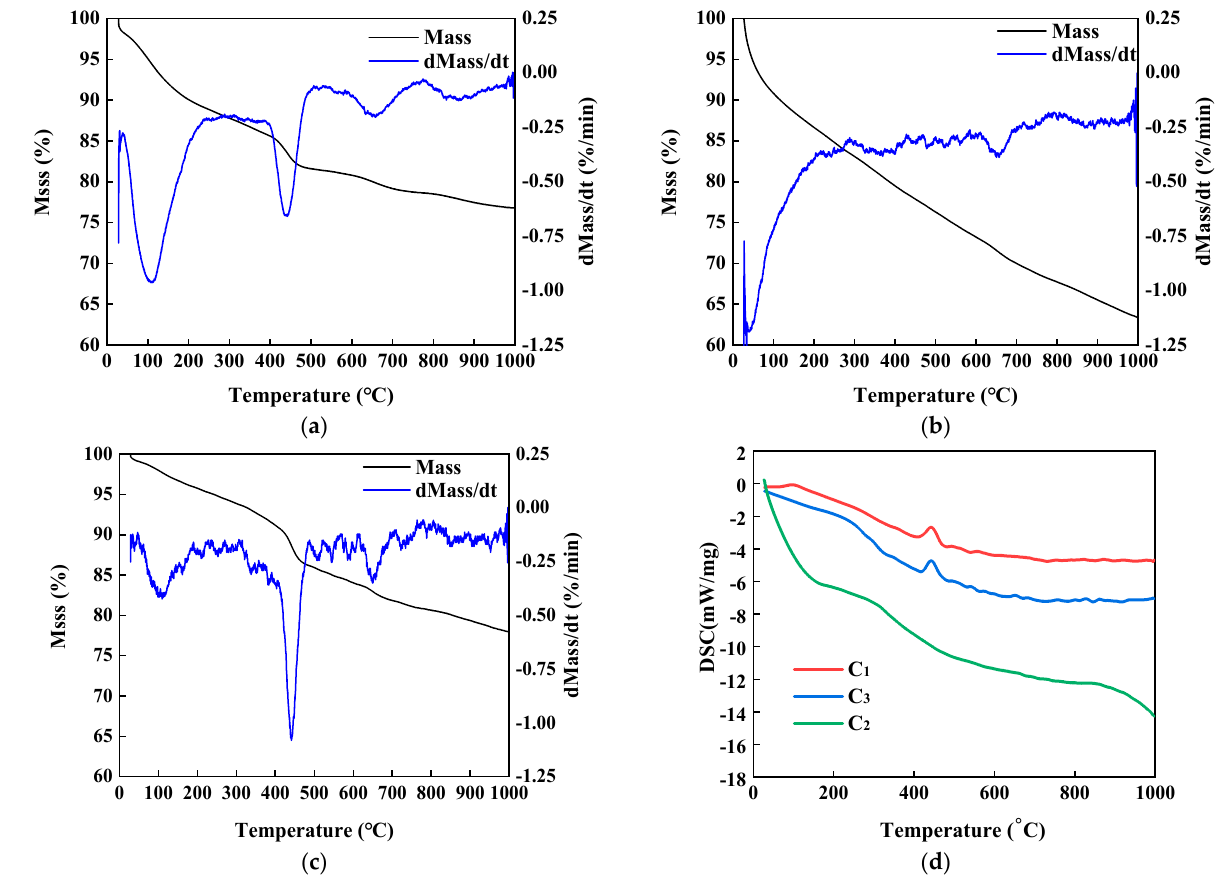
Figure 5. TG/DTG/DSC patterns of cement under different C/S and curing conditions. ( a ) TG/DTG tests for C1 (80 °C, C/S = 1.8); ( b ) TG/DTG tests for C2 (150 °C, C/S = 1.8); ( c ) TG/DTG tests for C3(150 °C, C/S = 1.1); ( d ) DSC tests.